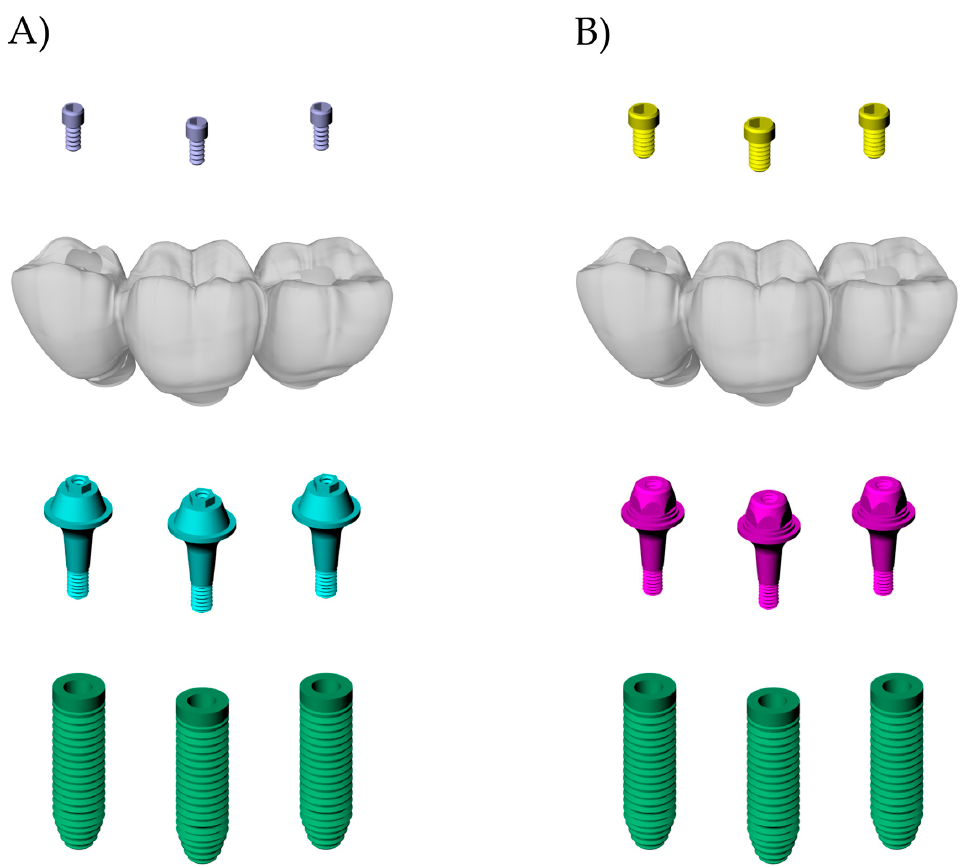
Figure 3. Final geometries according to the groups: ( A ) CMN; ( B ) MC. Table 1. Properties of the material used in the study.